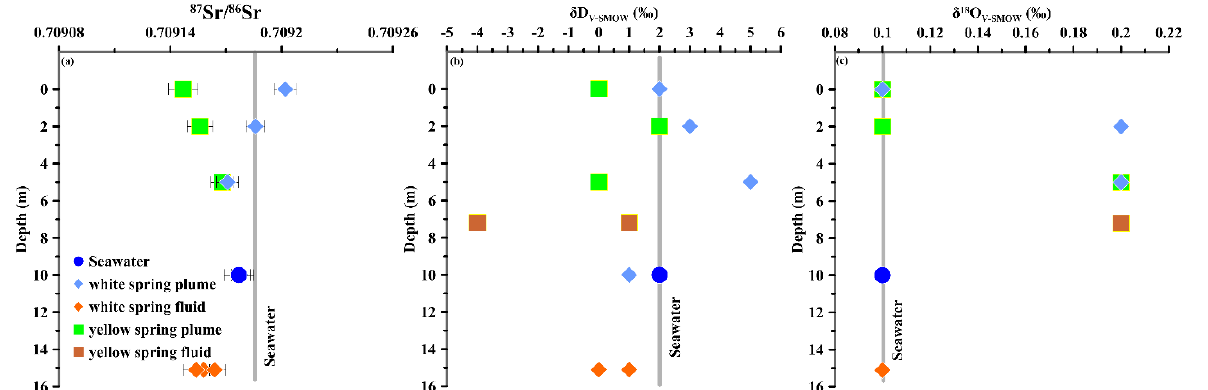
Figure 3. Variation of 87 Sr/ 86 Sr ( a ), δ D ( b ) and δ 18 O ( c ) values from hydrothermal fluid to plume at the yellow and white spring sites.